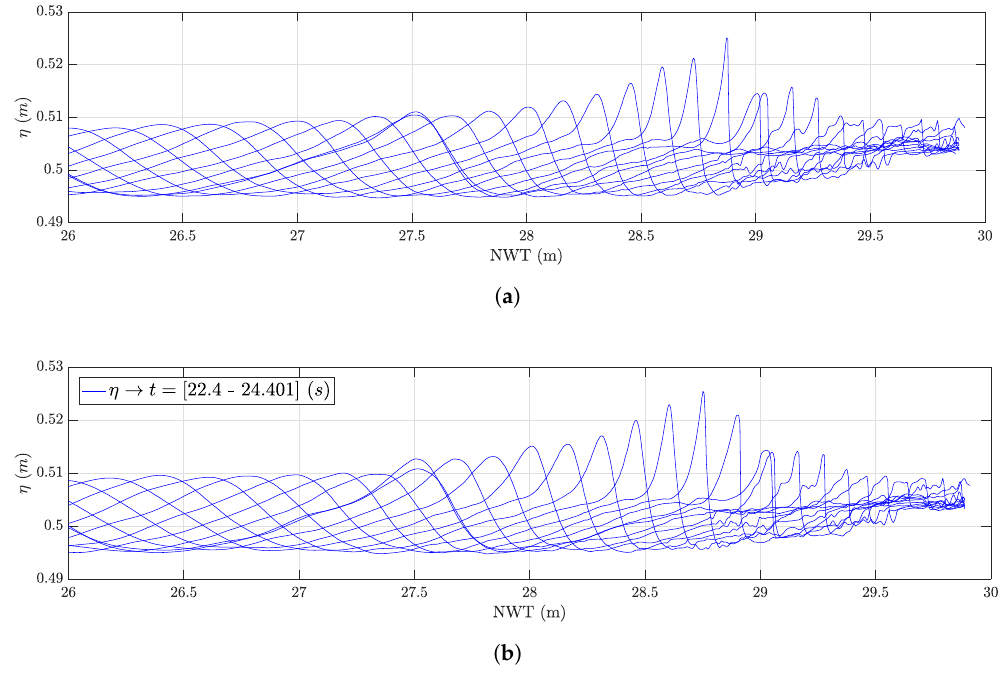
Figure 13. Free surface elevations in the tank showing wave breaking over a slope. ( a ) Case b from Table 3, using the RM; ( b ) Case b from Table 3, using